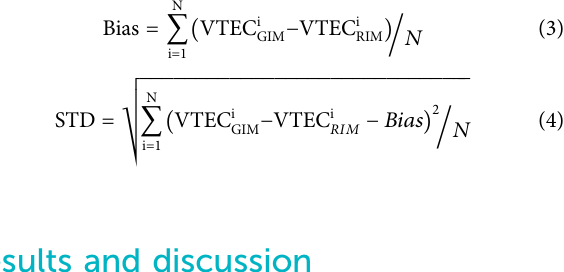
Frontiers in Earth